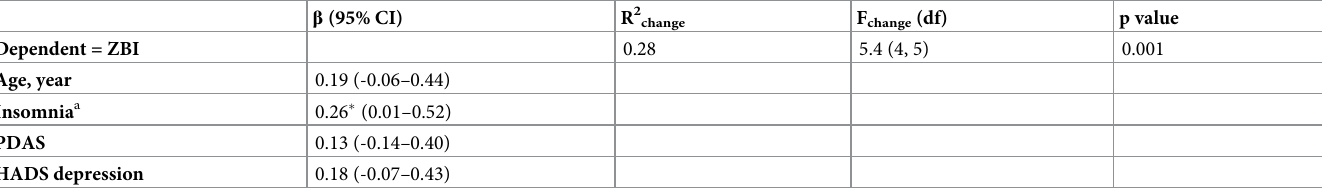
Table 3. Multiple regression analysis examining predictors of Zarit Burden Interview score. (n = 60). β (95% CI) R 2 change